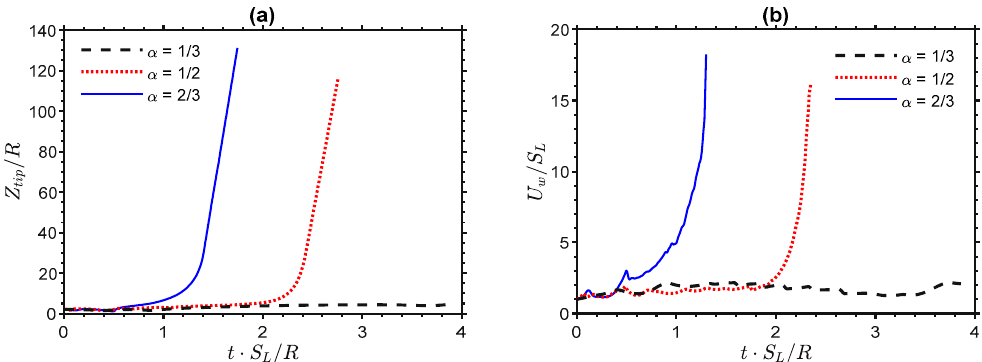
Figure 7. The scaled flame tip position Z tip / R ( a ) and the scaled burning velocity U w / S L ( b ) versus the scaled time τ = tS L / R for the Θ = 8 flame in the channels of half-width R = 36 L f with various blockage ratios α = 1/3, 1/2, 2/3.